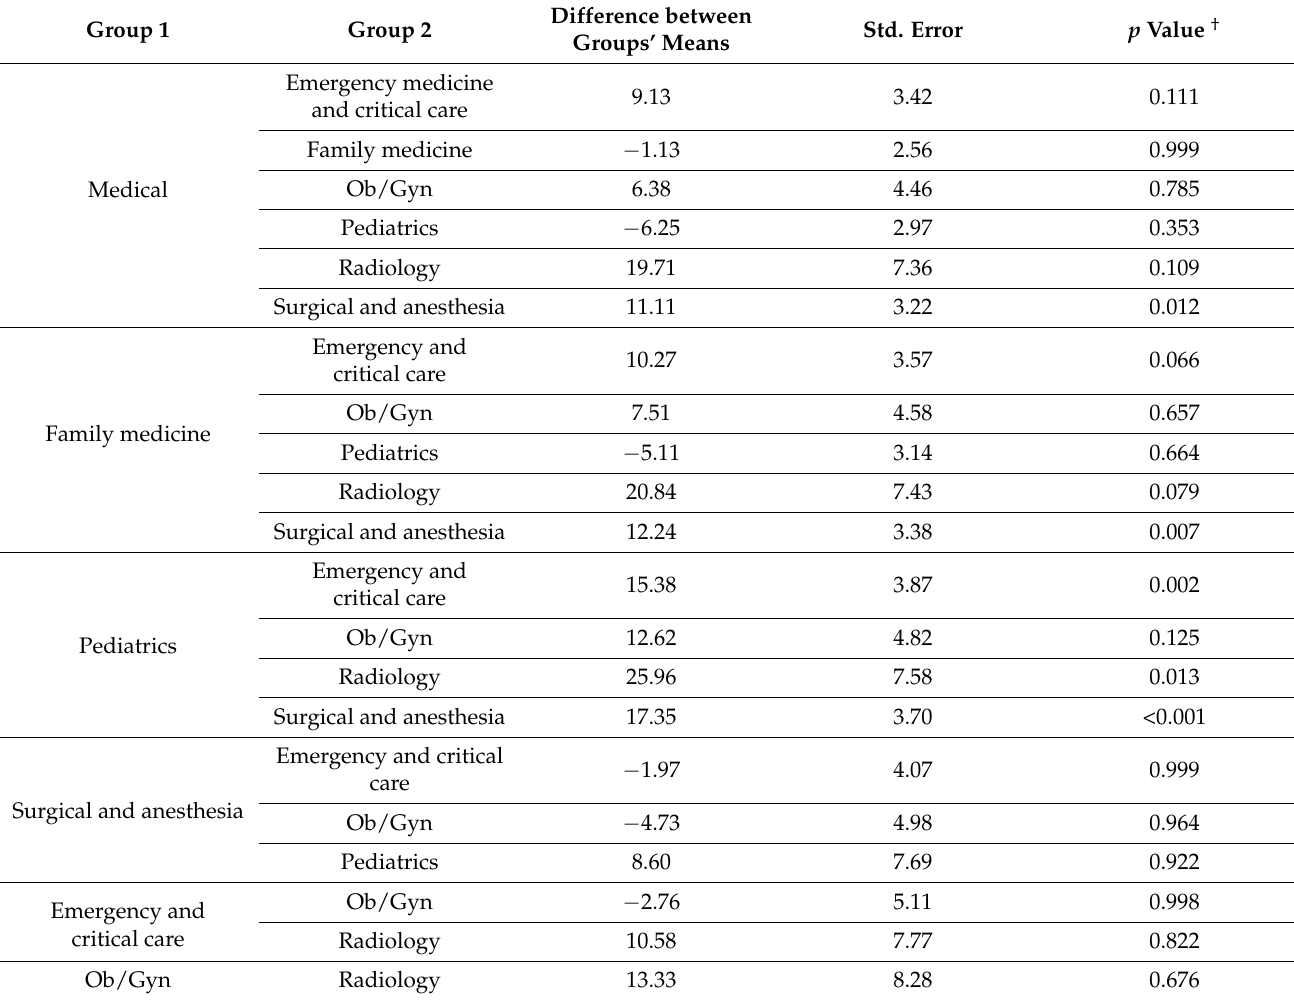
Table A1. Post hoc analysis of the differences in JSE means between residents’ specialties.